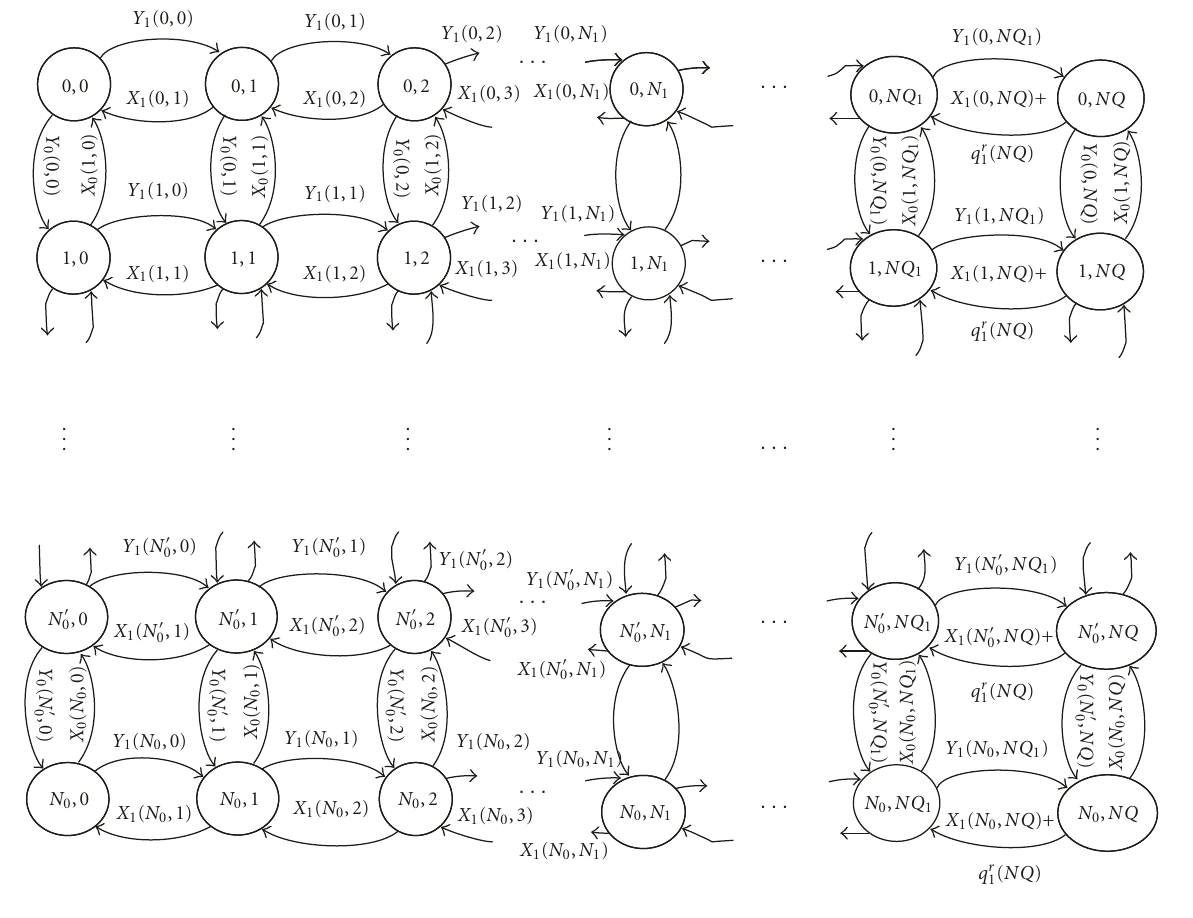
Figure 1: Markov state transition diagram for the system ( NQ 1 : N 1 + Q pq − 1; NQ : N 1 + Q pq ; N (cid:6) 0 : N 0 − 1) .